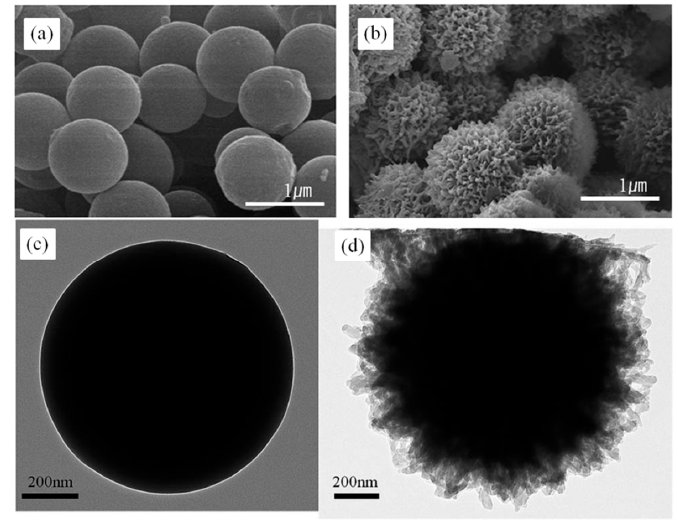
Figure 8. SEM ( a , b ) and TEM ( c , d ) images of polystyrene seed particle and urchin-like PS/PANI particle. (Kim et al. [128], Copyright The Royal Society of Chemistry, 2015).